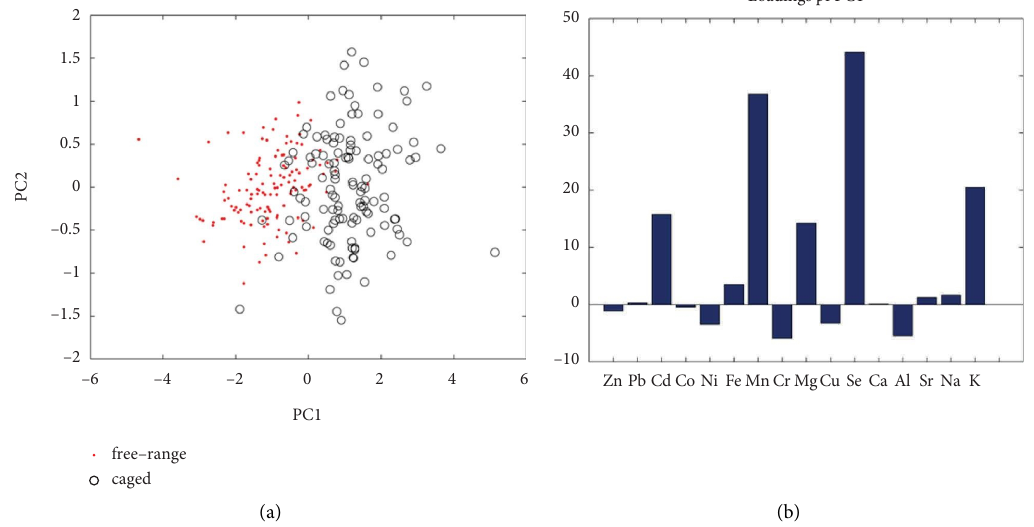
Figure 1: (a) Principal component 1 (PC1) and principal component 2 (PC2) score plot in free-range and caged eggshells. (b) PC1 loadings of the elemental profles of free-range and caged